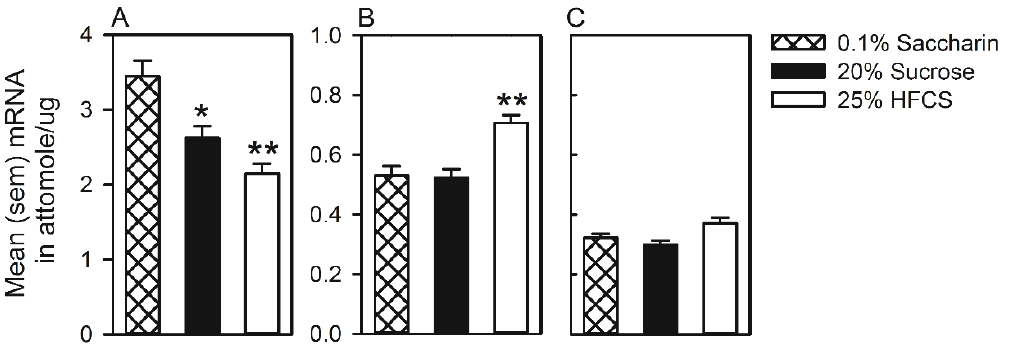
Figure 5. Mean (SEM) mRNA (attomole/μg) measured in the dorsal striatum ( A ), nucleus accumbens core ( B ) and nucleus accumbens shell ( C ) of rats that self-administered 25% HFCS, 20% sucrose or 0.1% saccharin. * Significant difference from 0.1% saccharin groups; ** significant difference from the 0.1% saccharin and 20% sucrose